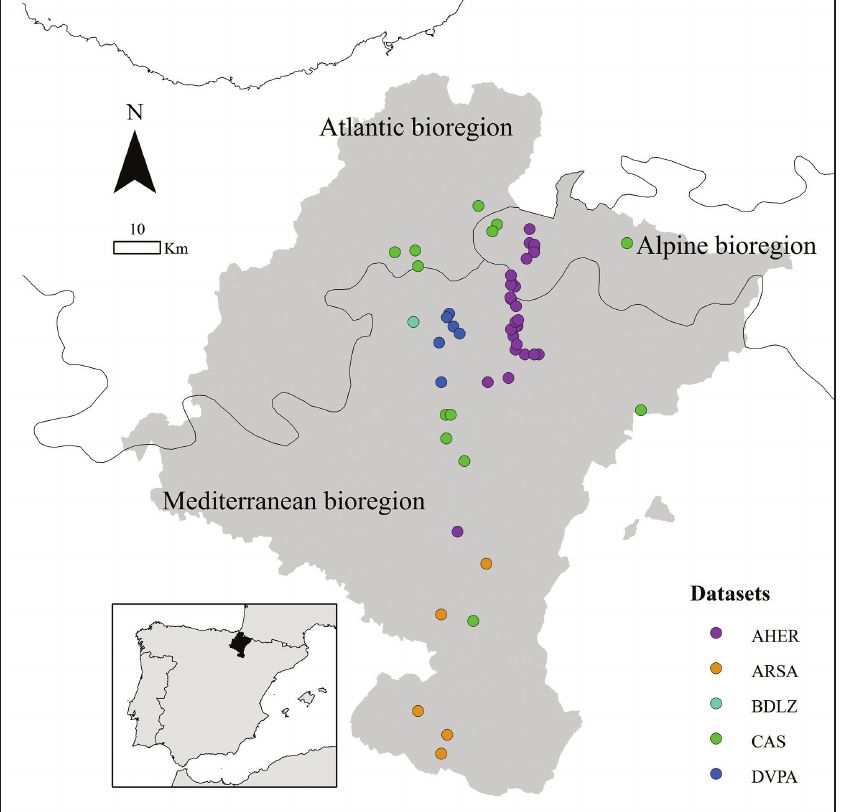
Figure 1. Study area: Navarra (inset, within Spain) and localities for the five datasets (AHER, ARSA, BDLZ, CAS,